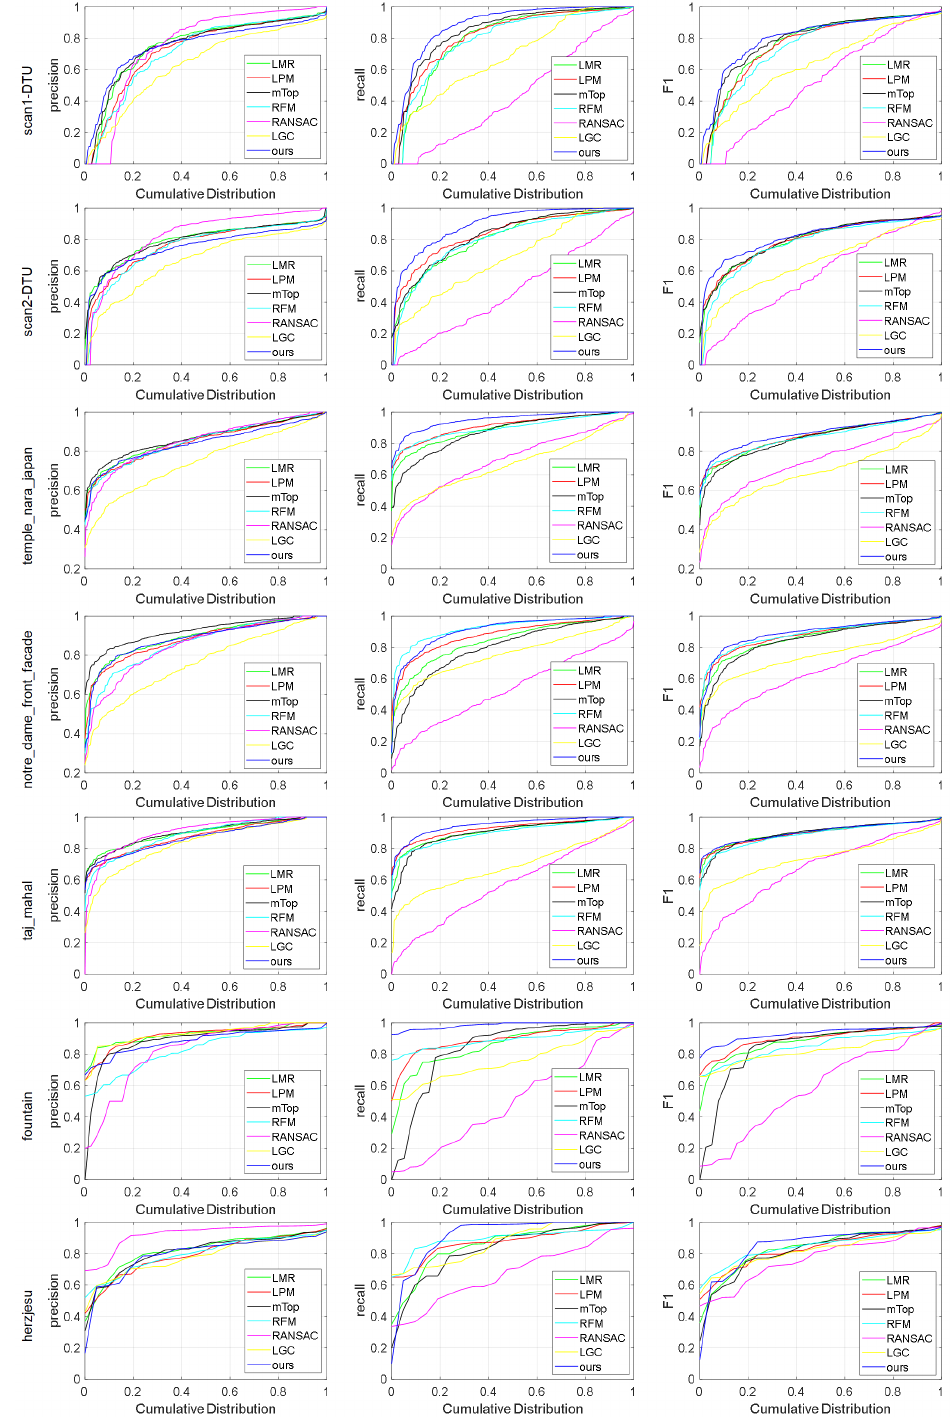
Figure 8. Results compared with several state-of-the-art methods. Each row is a scene. From top to bottom: scan1 and scan6 from DTU; temple_nara_japan, notre_dame_front_facade and taj_mahal from ChallengeData; fountain and herzjesu from Daisy. From left to right are: precision, recall and F1-score,